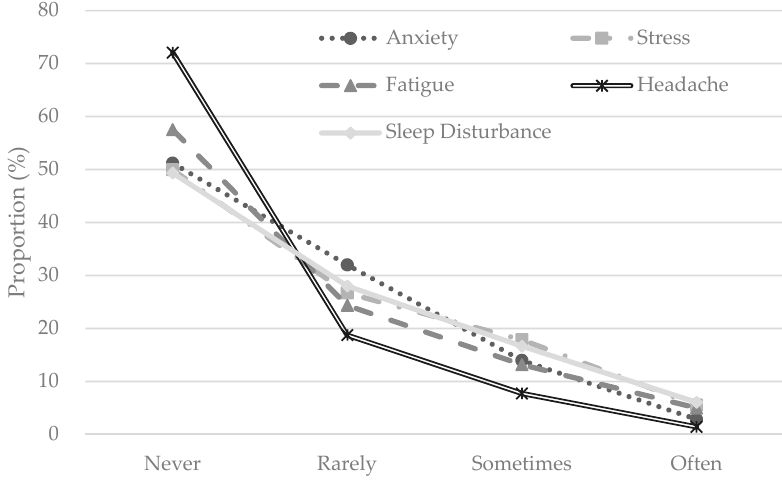
Figure 4. Population (%) in mental health categories.